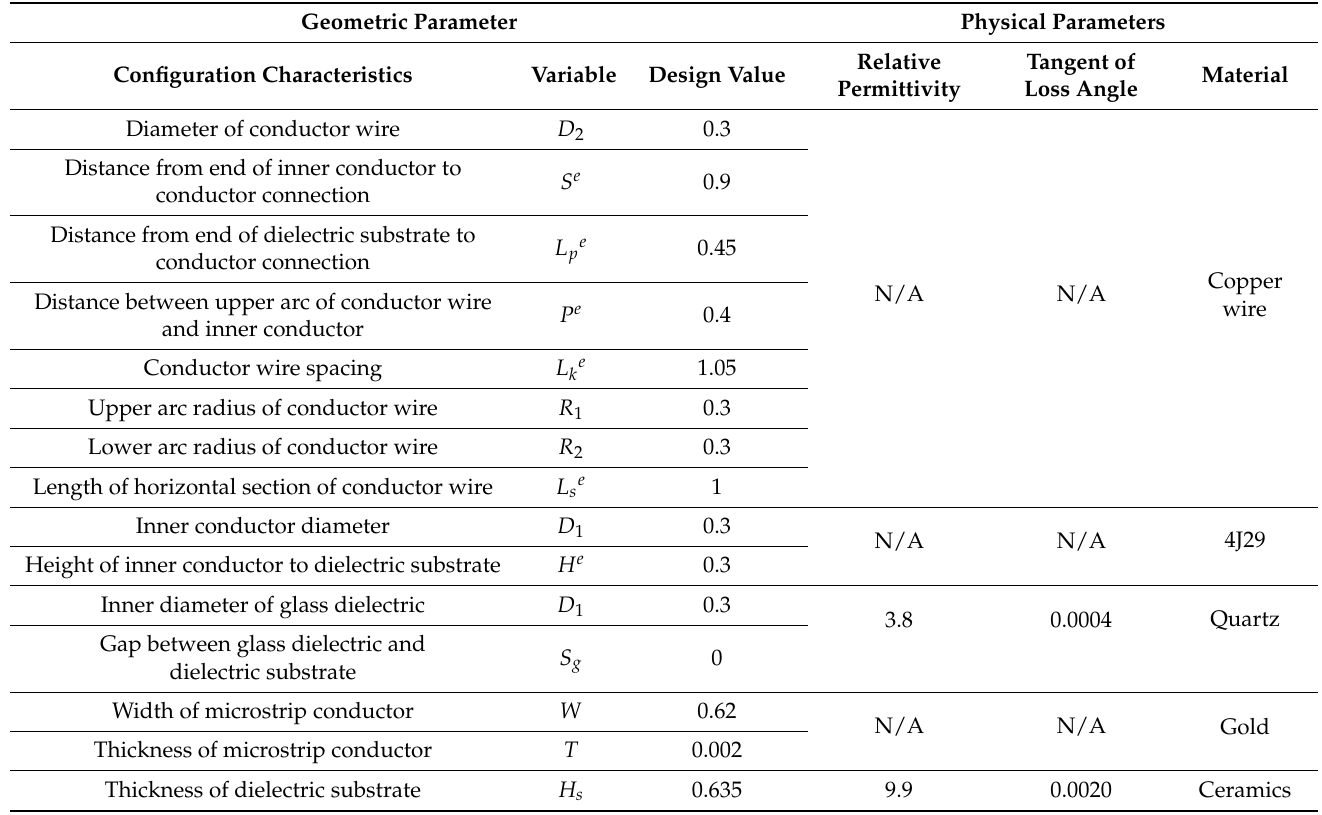
Table 4. Geometric and physical parameters of flexible interconnection.